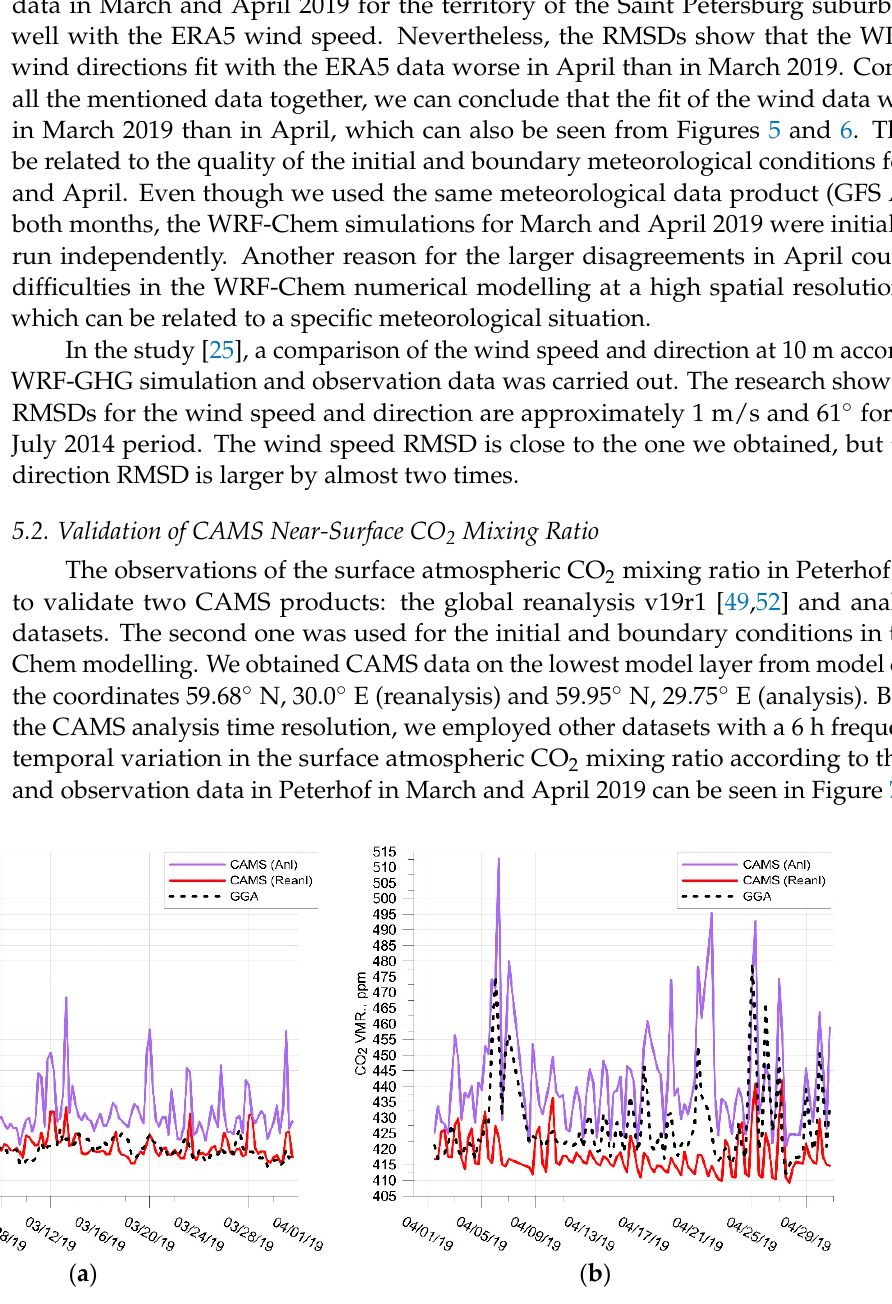
Figure 7. Temporal variation in the surface atmospheric CO 2 mixing ratio according to the CAMS and in situ observation data in Peterhof in March ( a ) and April ( b ) 2019.